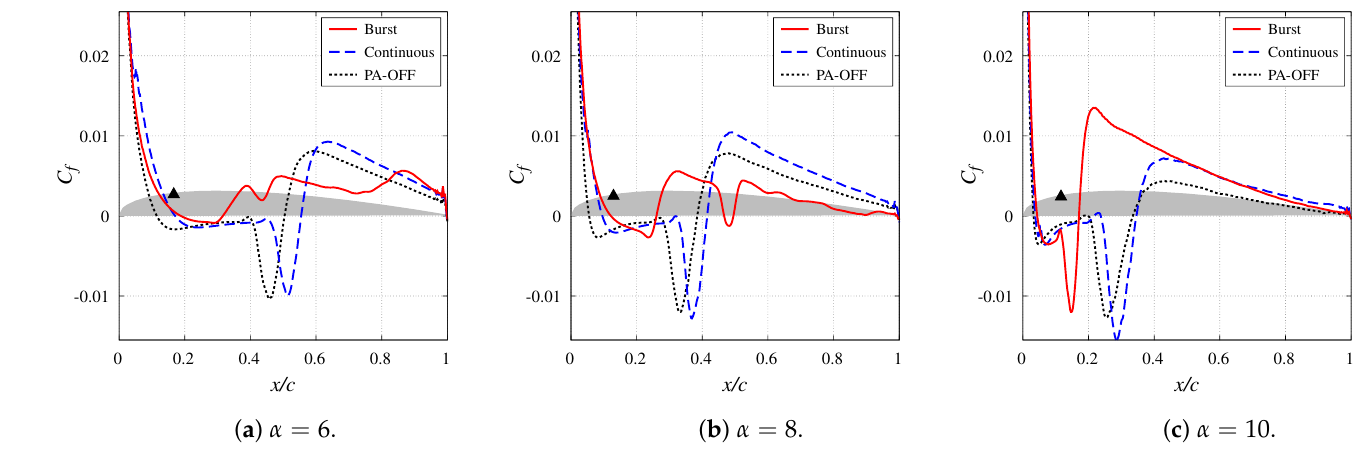
Figure 10. Skin friction coefficient ( C f ) distributions on the airfoil’s upper surface. The relationship between the flow field and the pressure distribution on the airfoil surface is discussed in more detail. Figure 11 shows time- and spanwise-averaged flows colored with the chordwise velocity normalized by the freestream velocity ( u / U ∞ ) for each case, and Figure 12 shows the displacement thickness ( δ ∗ ) on the airfoil’s upper surface. Figures 11 and 12 are helpful in understanding the separation bubble size in the wall- normal direction of the airfoil. The displacement thickness is nondimensionalized by the chord length. The NACA0015 airfoil is shown in the background to the same scale as the displacement thickness. In all cases, the flow separates from around x / c (cid:39) 0.1, forming a separation bubble, although it is difficult to see in the Burst cases.